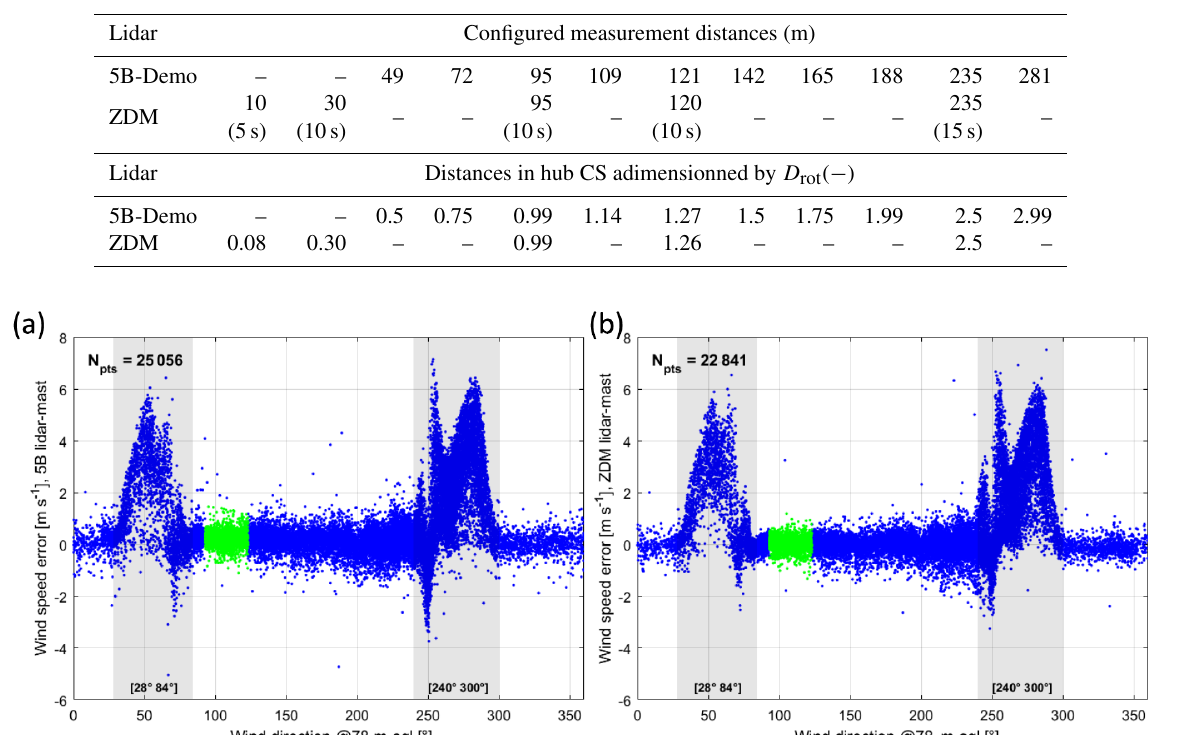
Figure 6. Analysis of horizontal wind speed error (lidar-reconstructed at 235m minus mast-measured). Grey shaded areas show wind directions with wakes. Data in green are in the selected sector. (a) 5B-Demo lidar. (b) ZDM